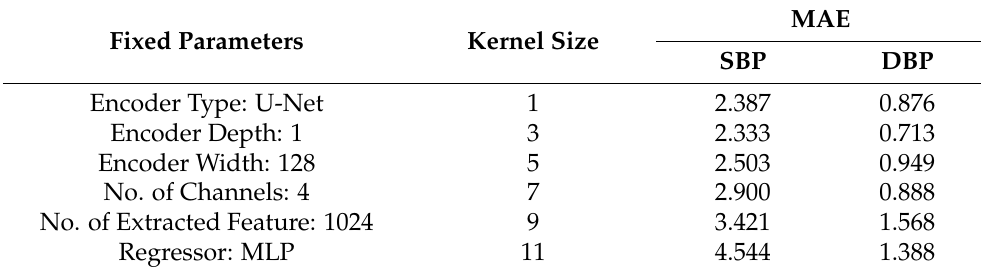
Table 7. MAE of BP prediction for variable kernel or filter size.